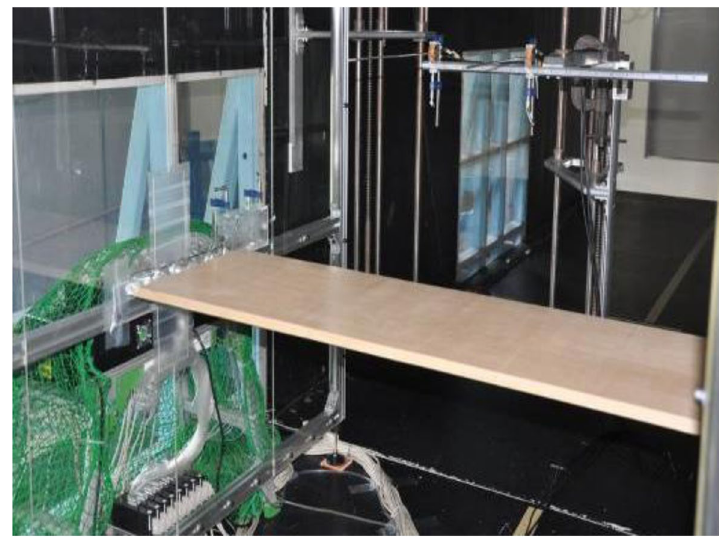
Fig. 12 Sectional model of pressure measurement test